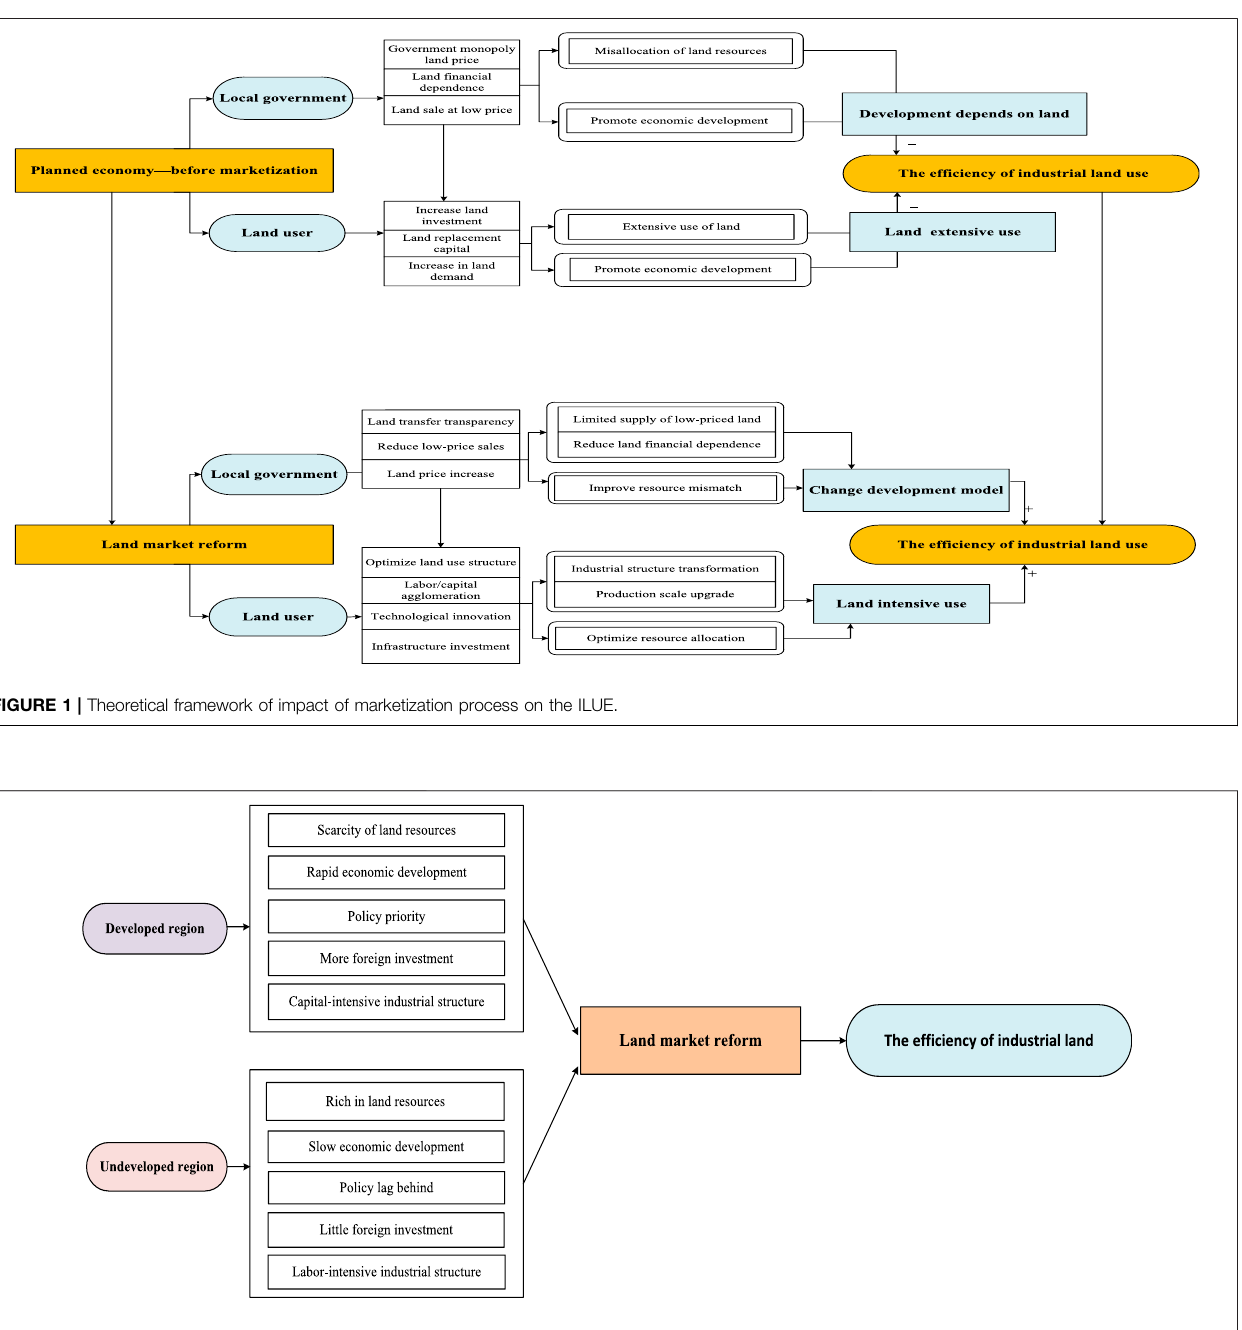
FIGURE 2 | Theoretical framework of MRIL affecting the ILUE in different regions to different